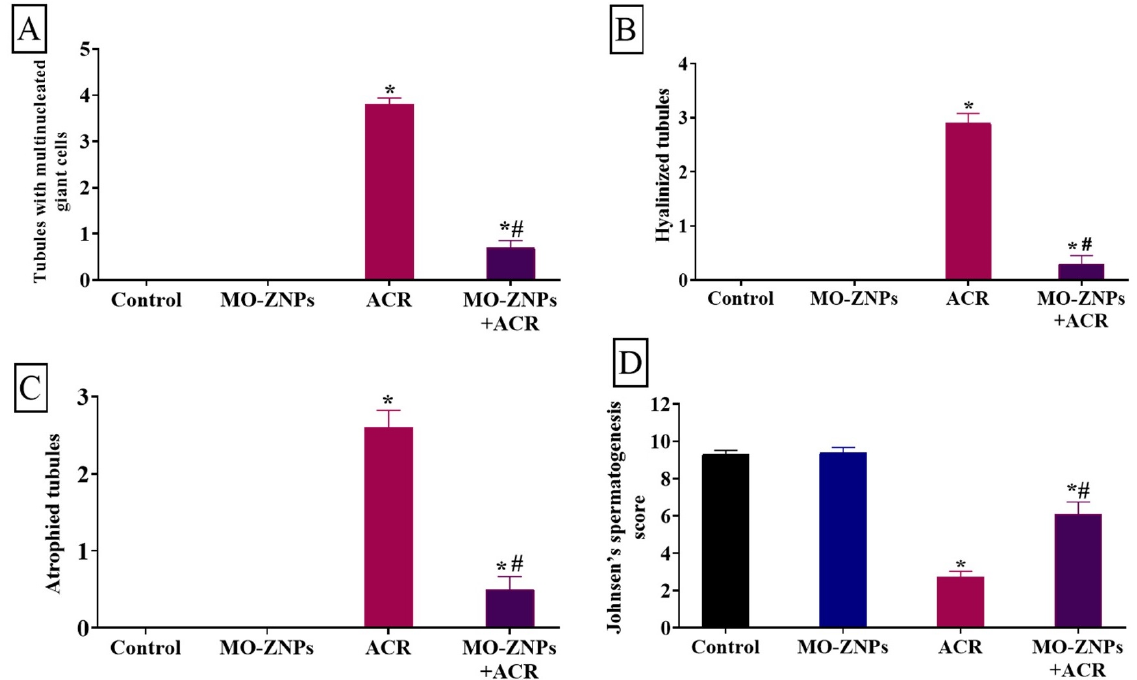
Figure 3. Changes in the testicular lesion score in rat testis of the different experimental groups ( A – C ) : ( A ) Tubules with Multinucleated giant cells; ( B ) Hyalinized tubules; ( C ) Atrophied tubules; ( D ) Johnsen’s spermatogenesis score. Bars represent the mean ± SE. n = 10 replicates/treatment. * p < 0.05 vs. control. # p < 0.05 vs. ACR.